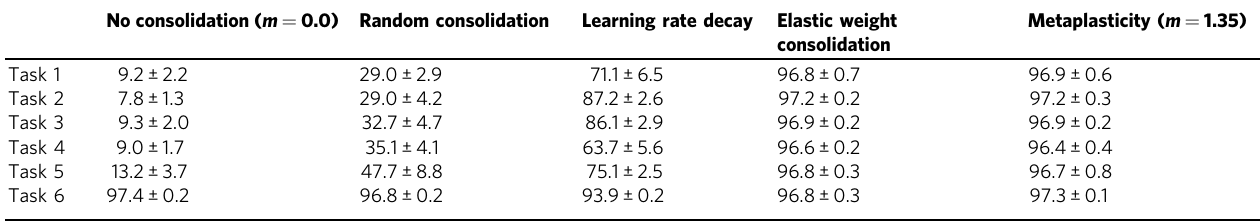
We indicate mean and standard deviation over fi ve trials, for a conventional (non-metaplastic) BNN ( m = 0.0), a task-dependent learning rate decay scheduler, consolidation of synapses with random importance factors, elastic weight consolidation (EWC) 3 computed with parameter λ EWC = 5 ⋅ 10 3 , and our metaplastic binarized neural network approach with parameter m =